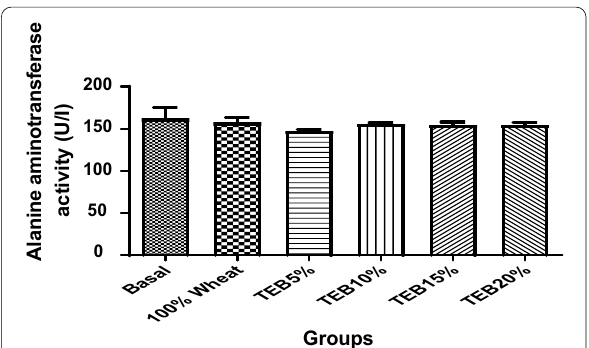
Fig. 6 Effect of enzymatic tacca–wheat biscuit on albino Wistar rats by alanine aminotransferase. 100% Wheat: Rats fed with 100% wheat flour biscuit, TEB5%: Rats fed with 5% enzymatic tacca flour wheat flour biscuit, TEB10%: Rats fed with 10% enzymatic tacca flour 90% wheat flour biscuit, TEB15%: Rats fed with 15% enzymatic + tacca flour 85% wheat flour biscuit, TEB20%: Rats fed with 20% + enzymatic tacca flour